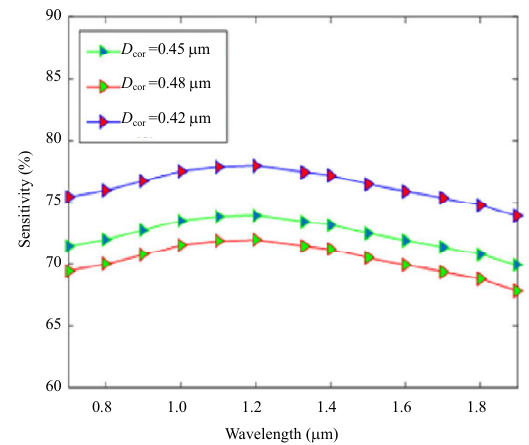
Fig. 4 Variation of sensitivity verses applied wavelength due to tuning the core diameter when other parameters are kept constant.